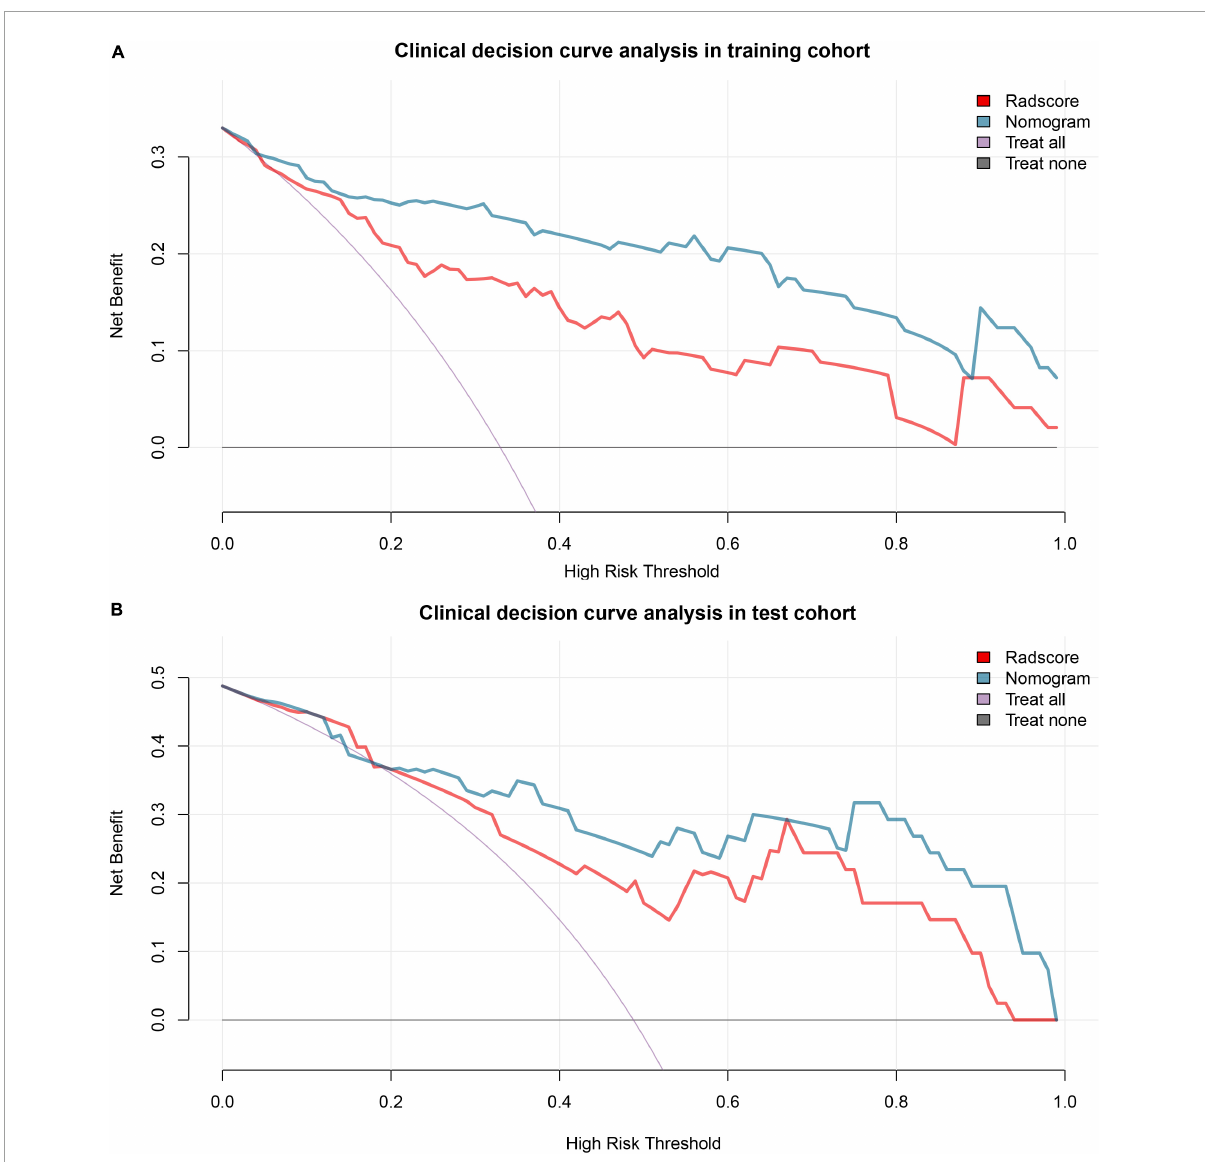
FIGURE5 Decision curve analysis. Decision curve analysis shows that the radiomics nomogram adds net benefit in predicting pre-eclampsia (PE) both in the training cohort (A) and test cohort (B) than treat all the patients as PE (purple line) or as gestational hypertension (GH) (black line). GH, gestational hypertension; PE,